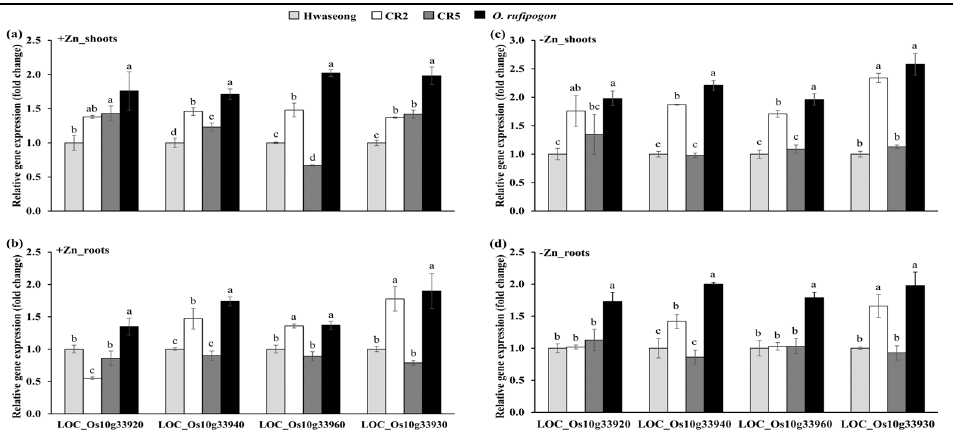
Figure 5. Quantitative real-time PCR analysis of the four candidate genes covering the qZn10 region. Relative expression levels of the four candidate genes in shoot tissues under ( a ) +Zn and ( c ) -Zn treatment conditions. Relative expression levels of the four candidate genes in root tissues under ( b ) +Zn and ( d ) -Zn treatment conditions. The mean values with different letters are significantly dif- ferent from each other at p = 0.05 based on Tukey’s test. Error bars represent the ± standard deviation of the mean. All values represent the mean of three replicates.